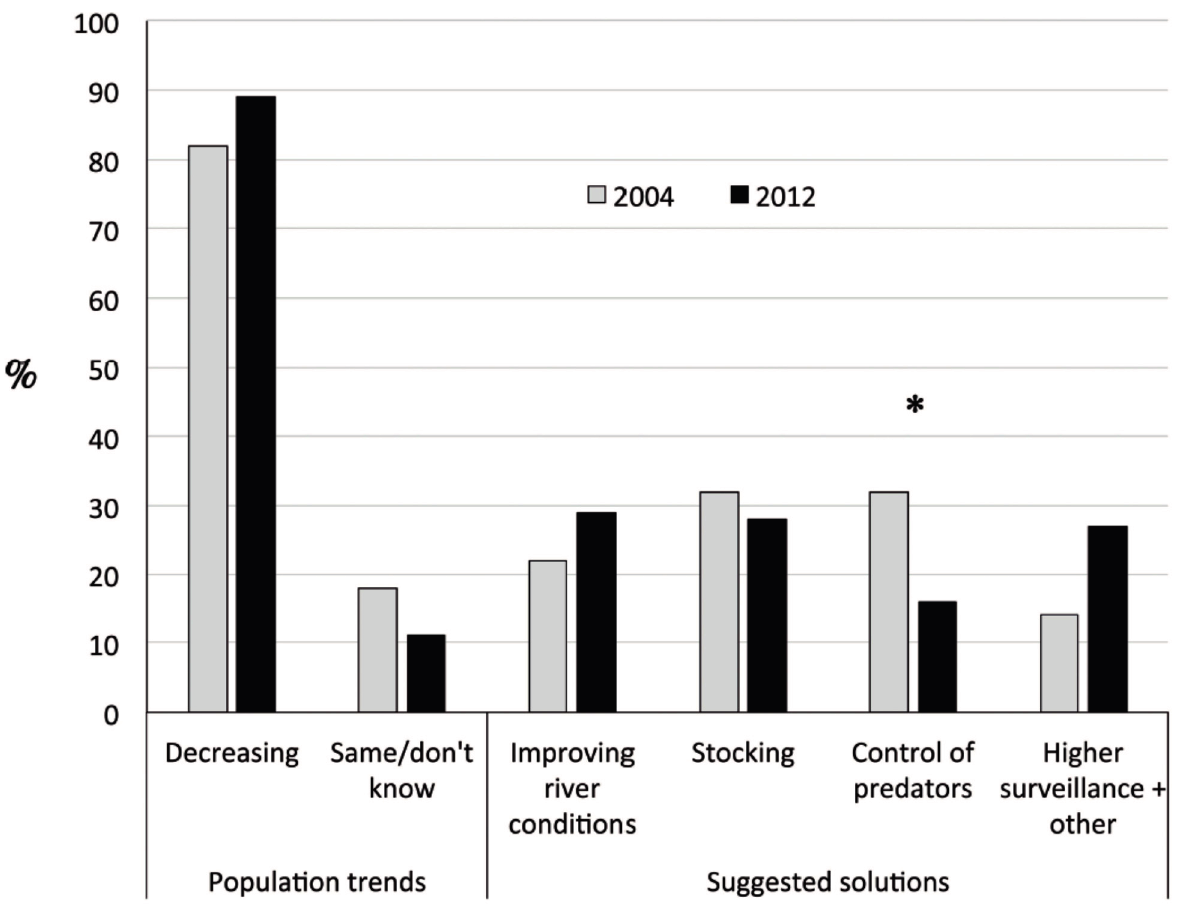
Figure 1. Results of the social survey in 2004 and 2012. Perception of local users of the river about the trend of Salmonid populations and possible solutions for improving their status, presented as percentage (%) over the total number of answers obtained for each